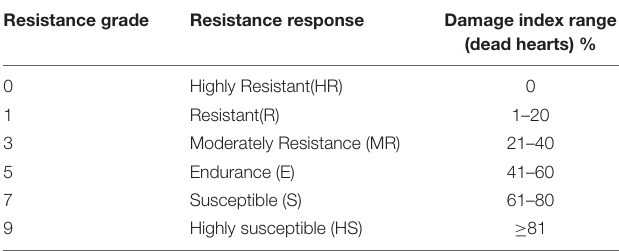
TABLE 1 | Grading standard for the strength of resistance ∗ . Resistance